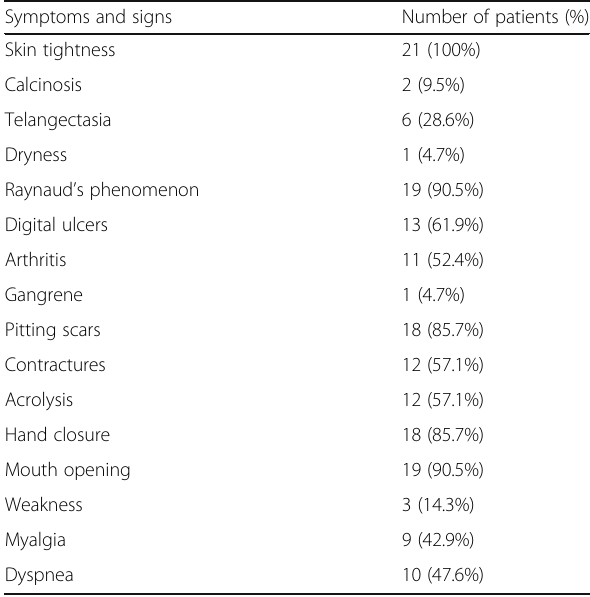
Table 1 Clinical data of SSc patients